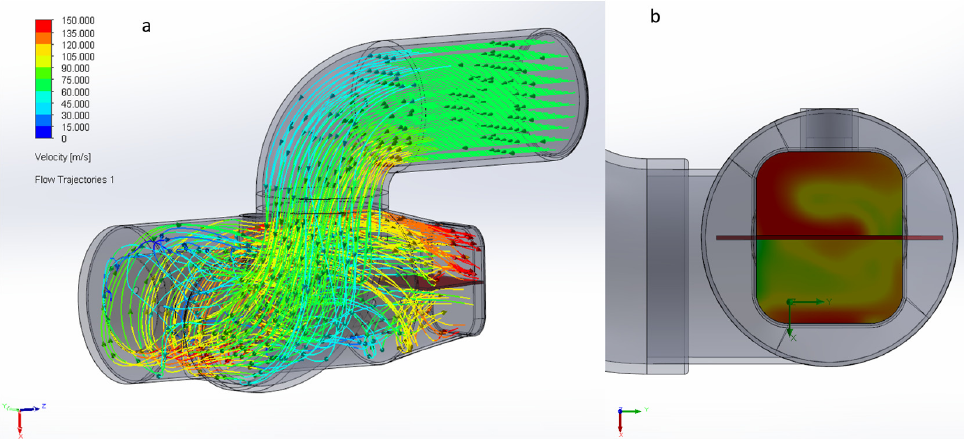
Figure 9. ( a ) The fin added design. ( b ) Velocity distribution of outflow.